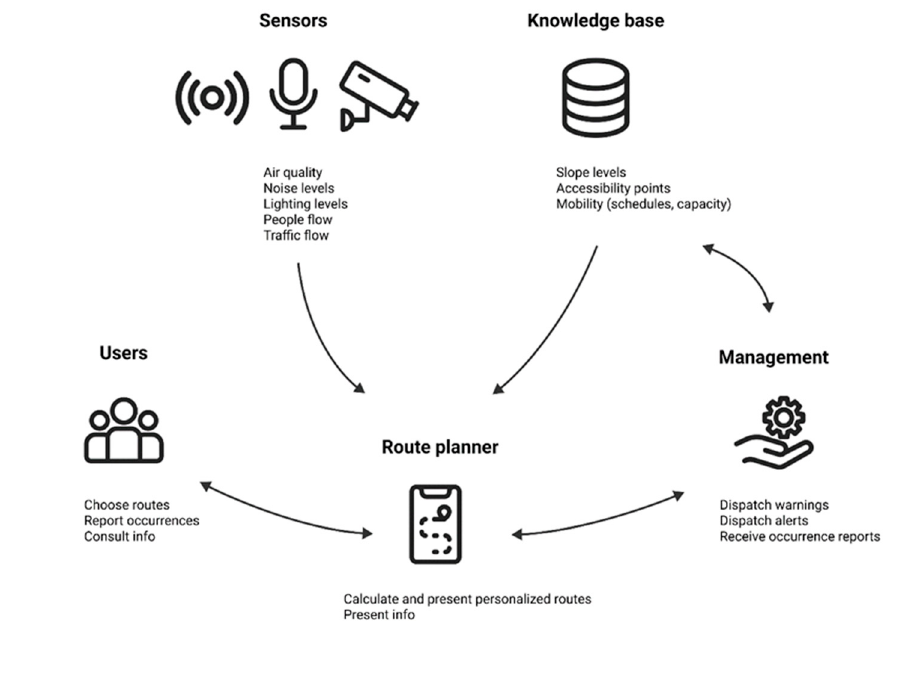
Figure 2. Components of the newly proposed route planner concept.